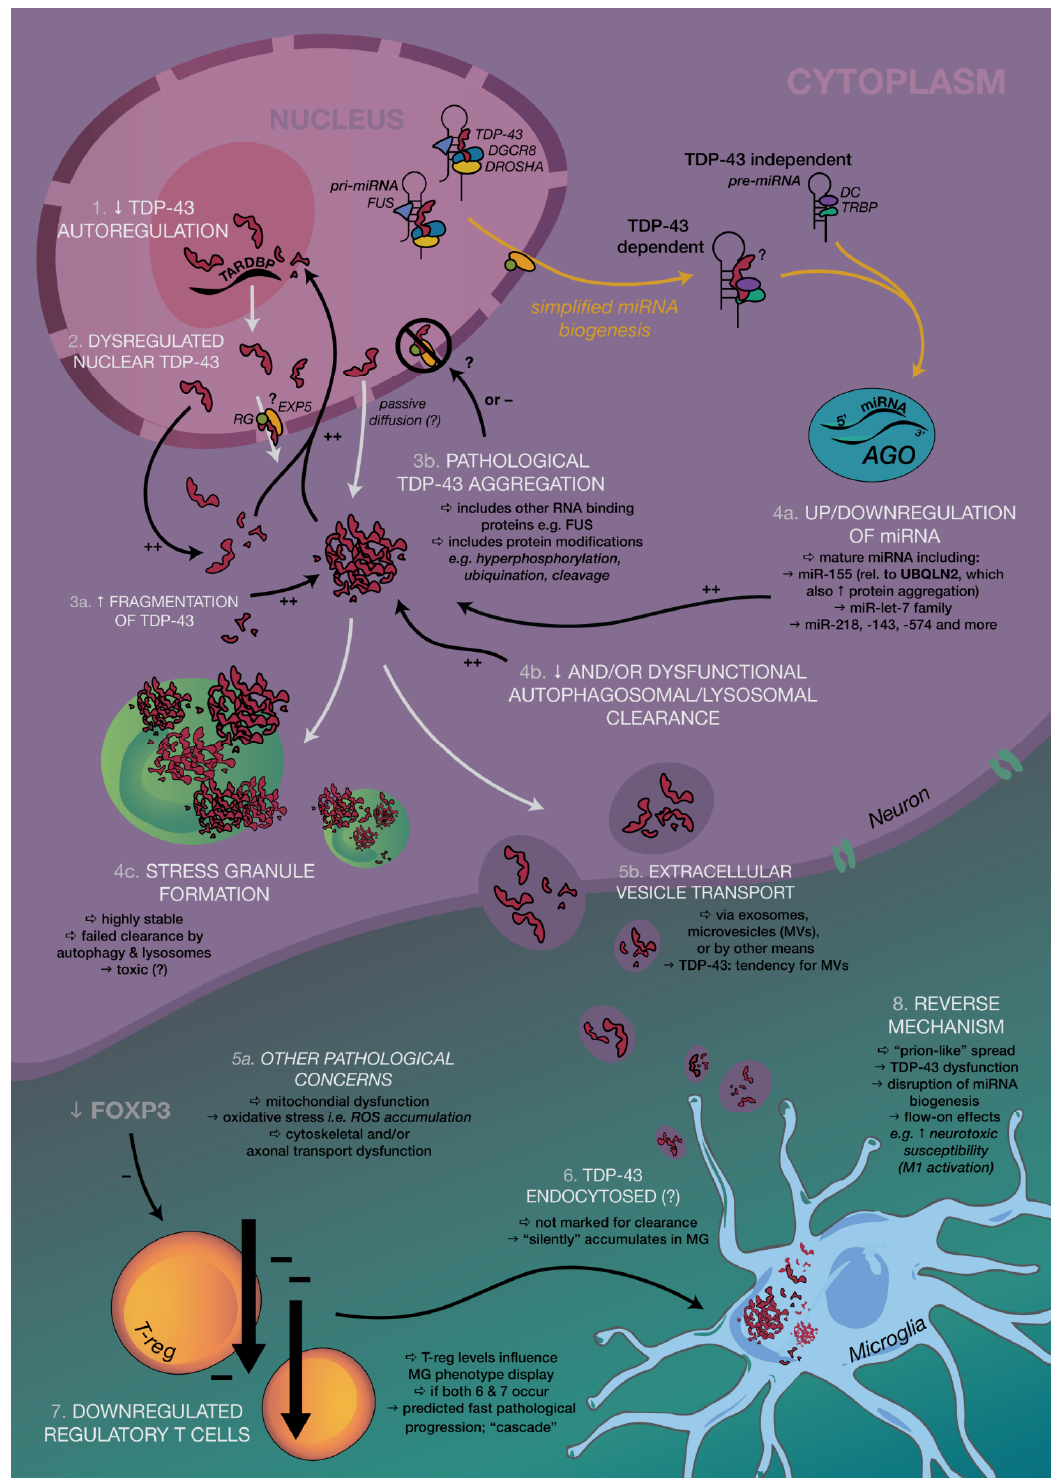
Figure 1. Simplified summary of key pathological mechanisms in a ‘network’ approach to Amyotrophic Lateral Sclerosis (ALS) involving transactive response DNA-binding protein (TDP-43), neurons, microglia, and regulatory T (T reg ) cells. See Appendix A for further details.